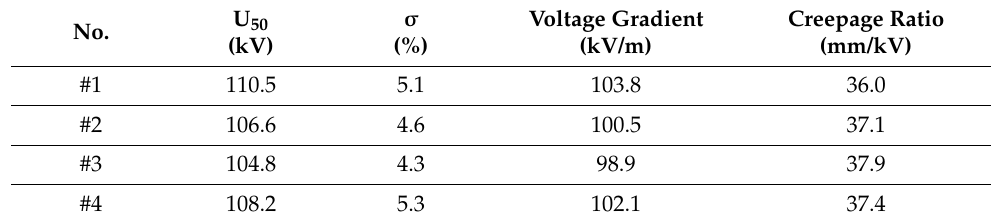
Table 6. Influence of umbrella structure on pollution flashover test results of composite crossarm insulators.